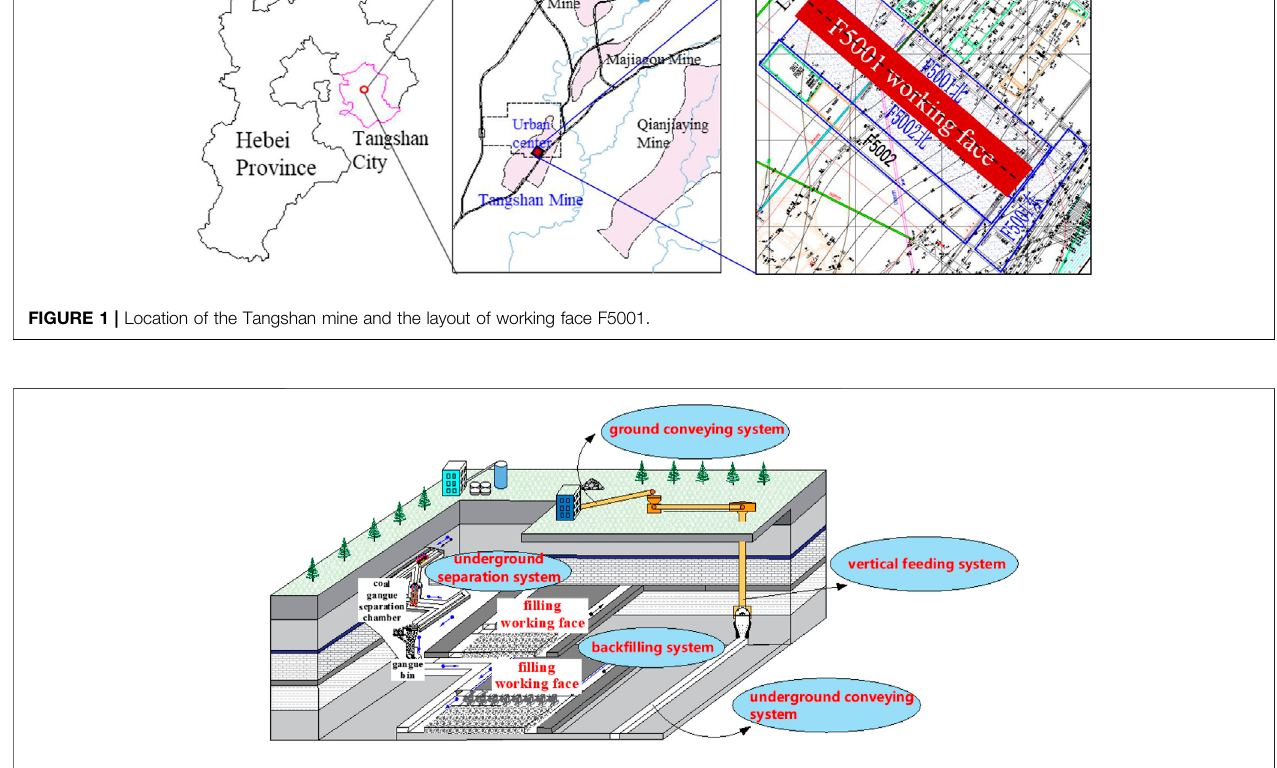
Frontiers in Earth Science |